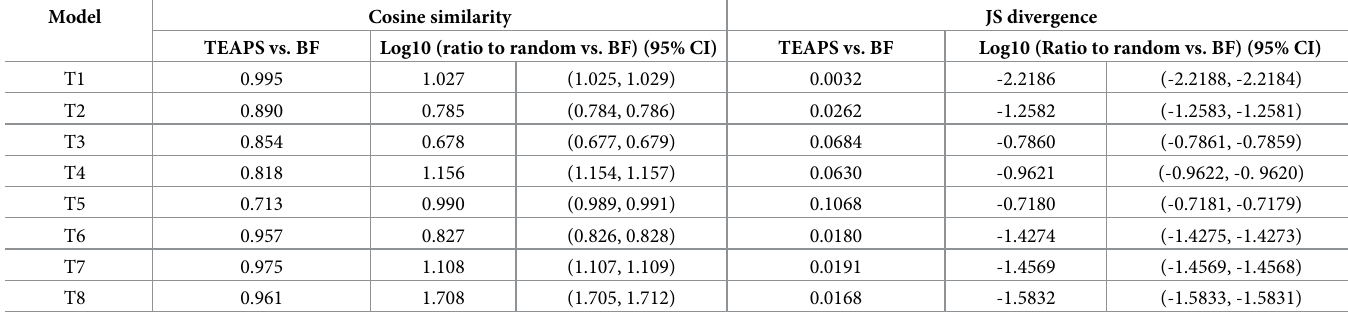
Table 1. Similarities between the distributions of the obtained parameter sets which met the BSR condition by TEAPS and the brute-force search. Model Cosine similarity TEAPS vs. BF